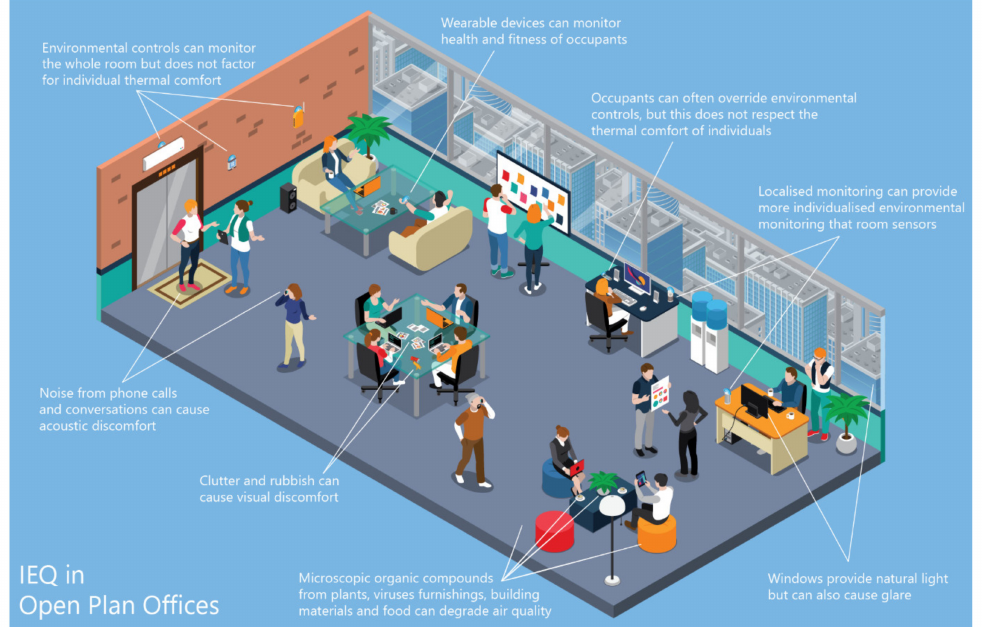
Figure 2. In Open Plan O ffi